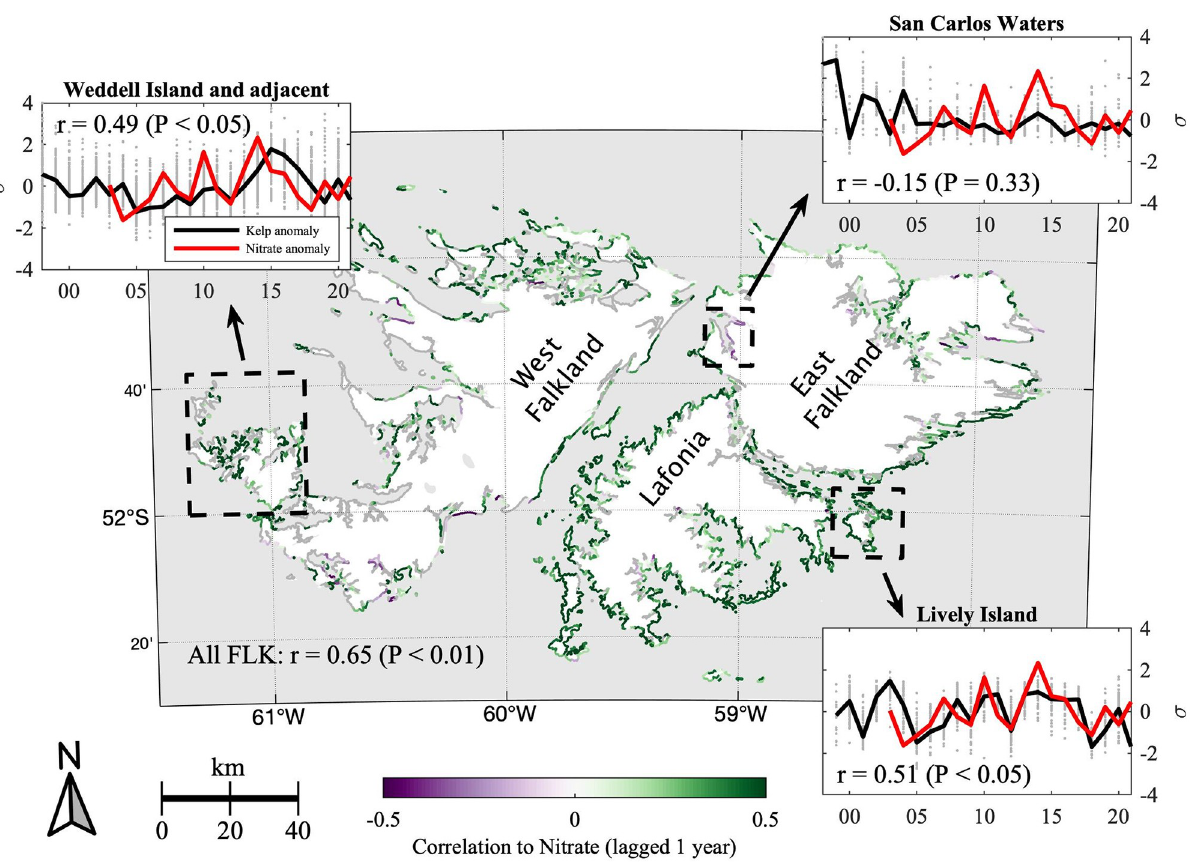
Fig 6. Spatial variability in correlation between standardized canopy extent and modeled nitrate concentration. Correlation coefficients for modeled nitrate concentrations and DTM standardized canopy extents are shown in purple and green for 1 km coastline subsets. If P � 0.01, coefficients are instead indicated in gray. Timeseries of select coastline subsets are shown in the figure inlays, with standardized kelp canopy extent indicated in gray for individual 1 km coastlines and in black for the combined sub-region, and with modeled annual nitrate shown in red. Years are indicated on the x-axis. The sub-regions included in the figure inlays are indicated with a dashed black line, and correspond as follows: Weddell Island and adjacent islands (upper left); San Carlos waters (upper right); and Lively Island (lower right).